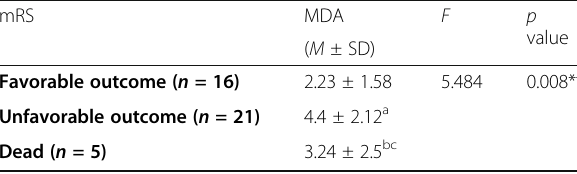
Table 3 Relation between mRS and Malondialdehyde in ischemic stroke